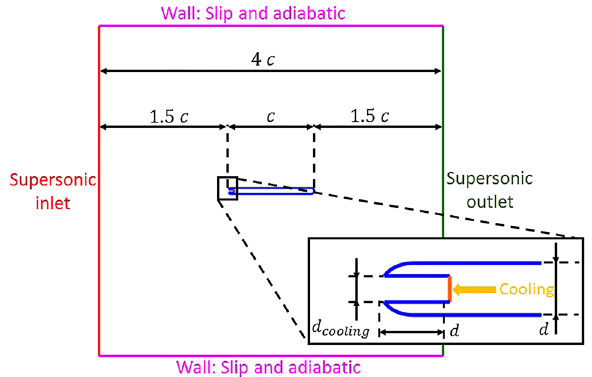
Figure 2. Computational domain and type of boundary conditions.